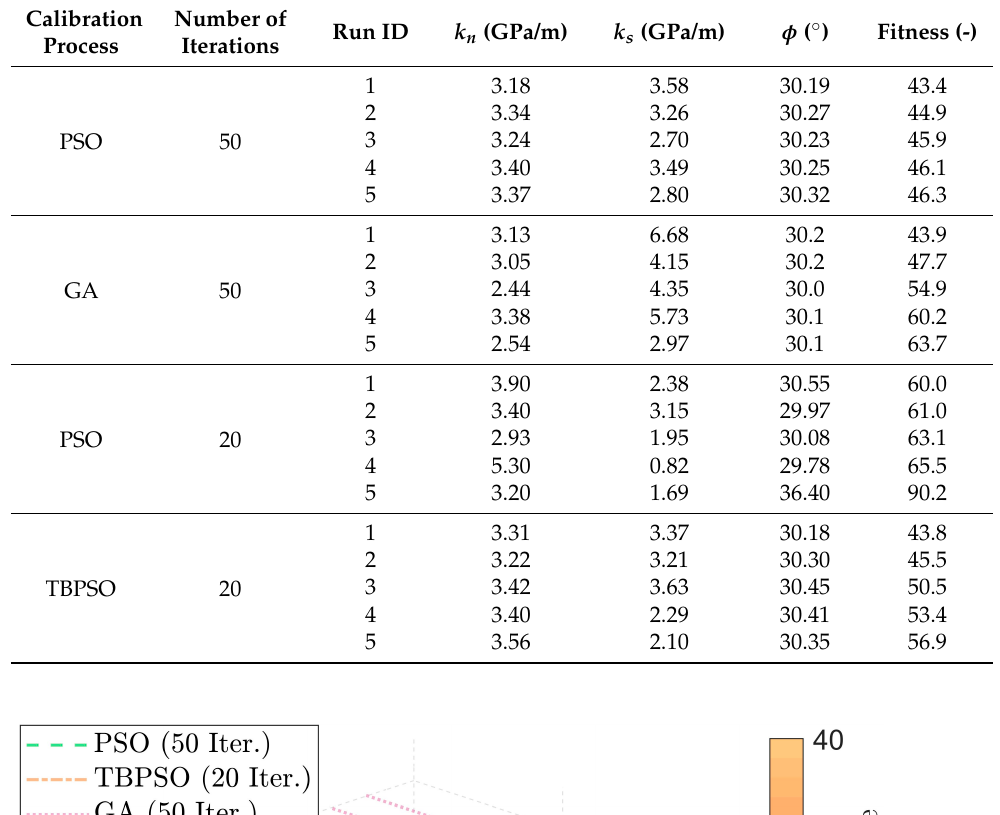
Figure 15. Best calibrated material parameter load displacement diagrams of Pulatsu’s geometry (objective function 1, PSO and GA: 50 iterations; TBPSO: 20 iterations); ( a ) vertical displacement, ( b ) horizontal displacement.